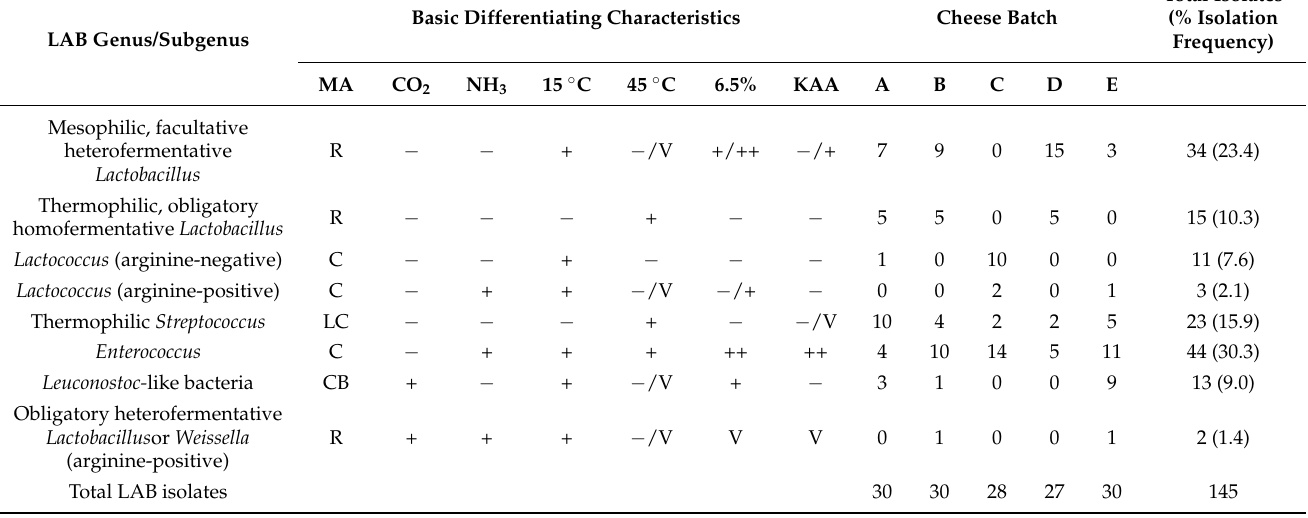
Table 2. Biochemical characterization and grouping of the 145 LAB isolates from RTE Galotyri-like acid-curd cheese at the genus/subgenus level in accordance to their numerical distribution in each of the five cheese batches analyzed, and their total percent isolation frequency.